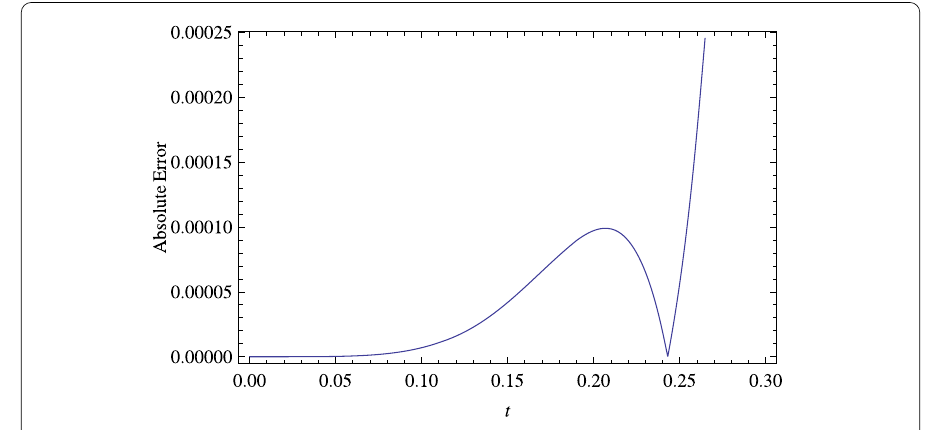
Figure 9 Plot of the absolute error of TFNWS equation when (cid:2) = –1 and λ = 1